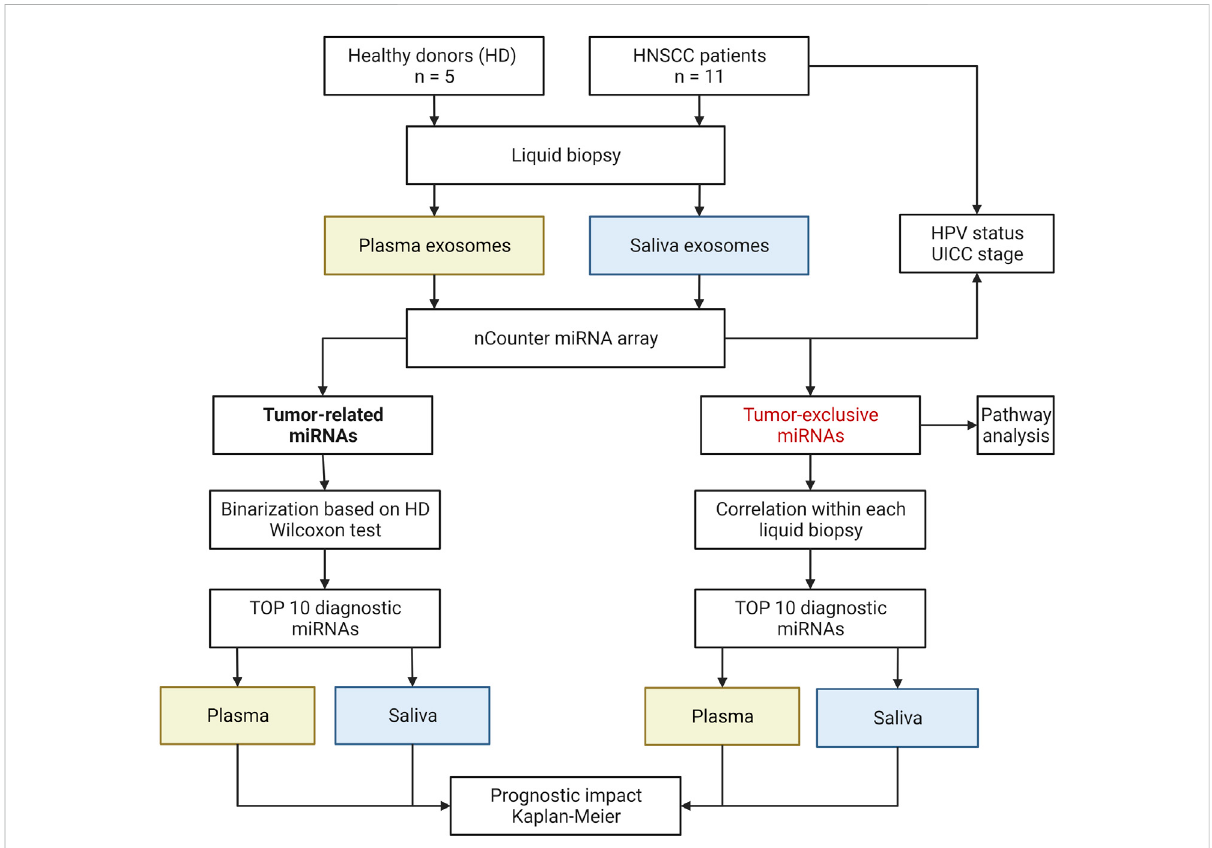
FIGURE 1 Schematic study work fl ow. HD, healthy donor: HPV, human papilloma virus: UICC, Union for International Cancer Control. Created with BioRender.com.